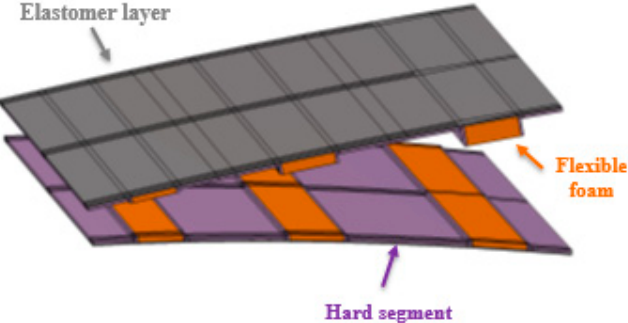
Figure 10. Functional segments of morphing skin: structural layer, elastomer and flexible gapless foam.